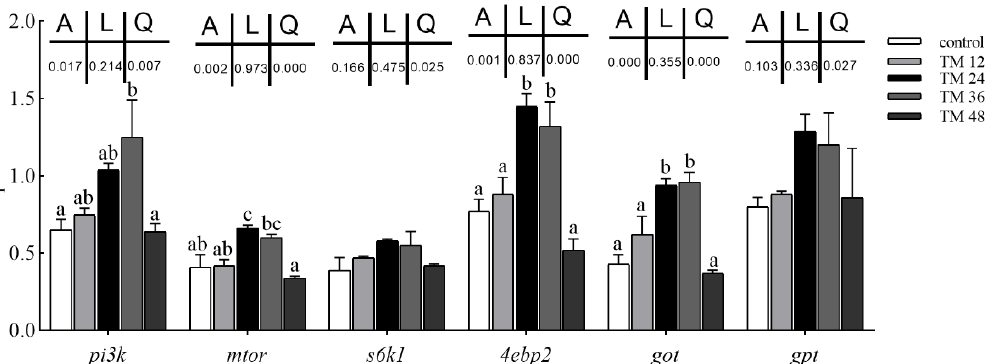
Figure 2. Effects of different levels of TM, instead of FM, on the expression of protein metabolism genes in the liver of Micropterus salmoides. Values with different letters represent significant differences in Tukey’s test ( p < 0.05). A = the variance analyzed by one-way ANOVA; L = linear trend analyzed by orthogonal polynomial contrasts; Q = quadratic trend analyzed by orthogonal polynomial contrasts. Table 8. Effects of fishmeal replacement with TM on hepatic antioxidant capacity and protein metabolism in Micropterus salmoides a .